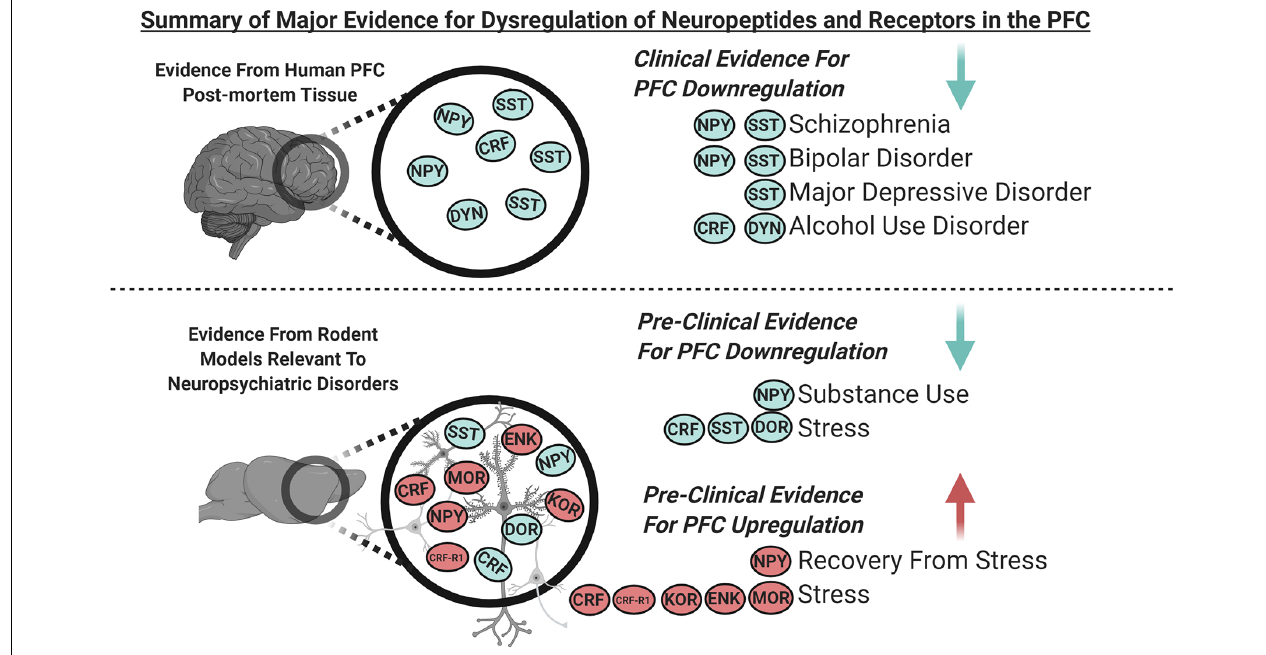
FIGURE 1 | Graphical summary of the major clinical and pre-clinical findings covered in this review demonstrating dysregulated expression of neuropeptides and their receptors in the prefrontal cortex (PFC; blue indicates downregulation and red indicates upregulation). Clinical evidence from PFC of human post-mortem tissue indicates downregulation of somatostatin (SST) and neuropeptide Y (NPY) in schizophrenia and bipolar disorder, SST in major depressive disorder (MDD), and corticotropin-releasing factor (CRF) and dynorphin (DYN) in alcohol use disorder. Pre-clinical evidence from the PFC of rodent models relevant to neuropsychiatric disorders indicates that; NPY is downregulated with substance use, SST, and delta-opioid receptors (DOR) are downregulated following stress. NPY is upregulated during recovery from stress, and CRF receptor 1 (CRF-R1), kappa opioid receptors (KOR), enkephalin (ENK) and, mu-opioid receptors (MOR) are upregulated following stress. CRF is downregulated following acute stress and is increased following chronic